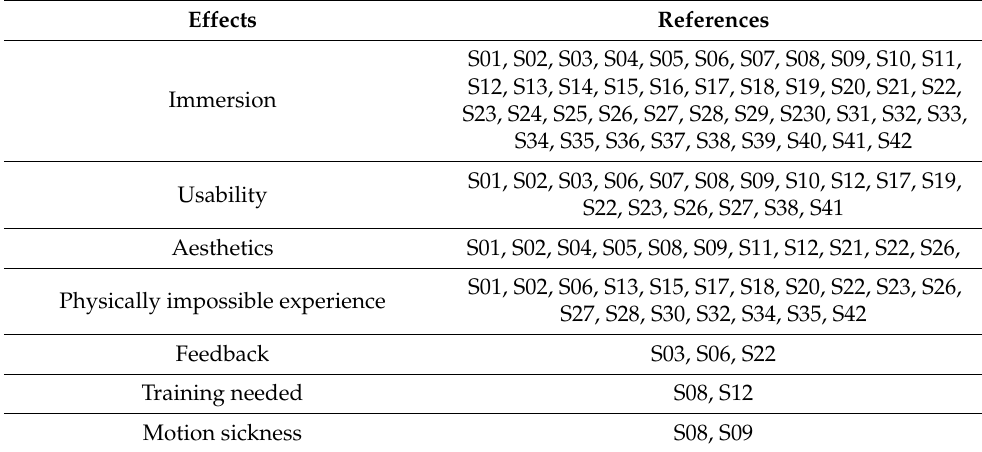
Table 8. Player experience (selected studies).